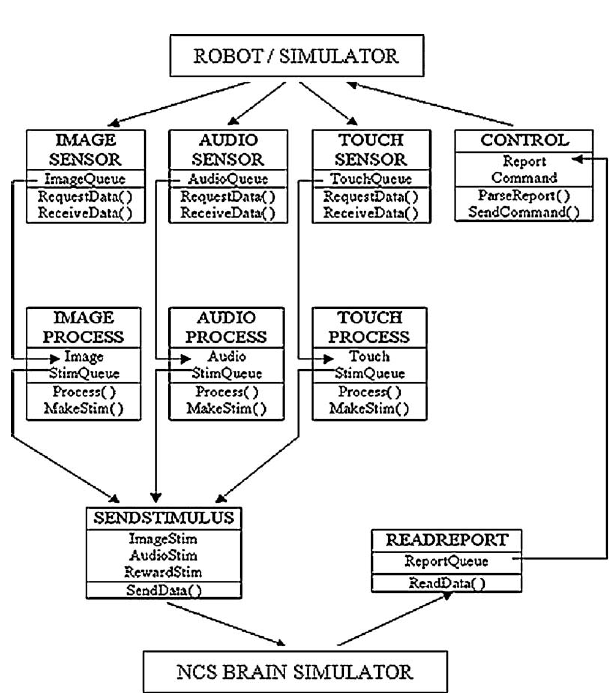
Figure 2. Multi-threaded pipeline organization of the BRAINSTEM . Each sensory or report modality is assigned its own thread in a self-blocking queue. Data are read from a hard drive shared with sensory capture software. Outputs back to the robotic system and to the NCS brain simulator are sent by TCP/IP port routing. Documentation is available at